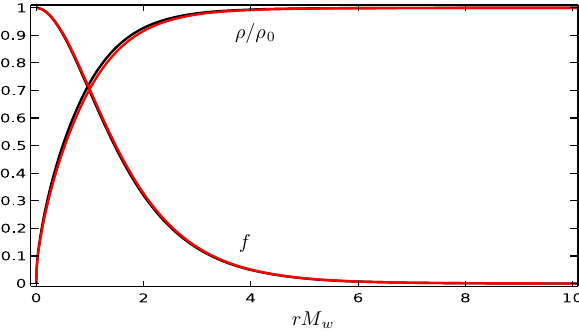
Fig. 4 The finite energy electroweak monopole solution regularized by the electromagnetic permittivity with W boson and Higgs scalar dressing. The red curve represents the regularized monopole solution with the non-trivial permittivity ¯ (cid:14) 1 = (ρ/ρ 0 ) 6 . For comparison we plot the monopole solution regularized by the hypercharge renormalization with the black curve (shown in Fig. 1)